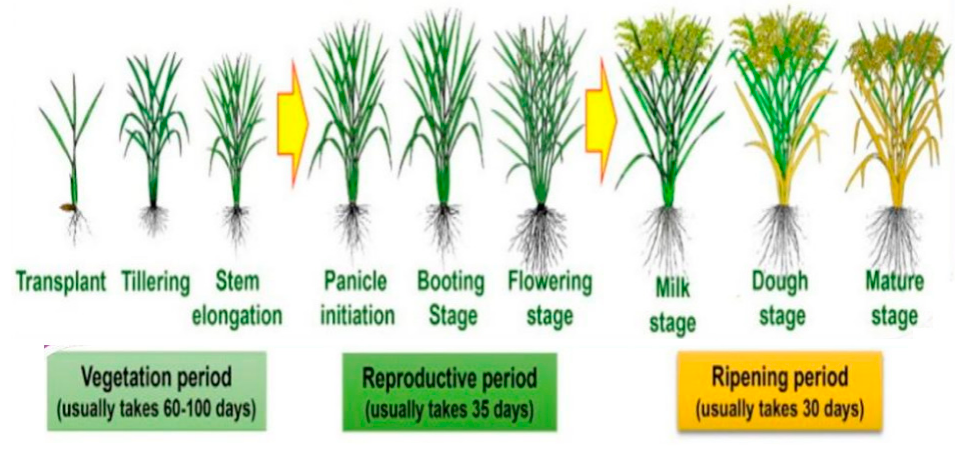
Figure 1. Rice plant growth stages.